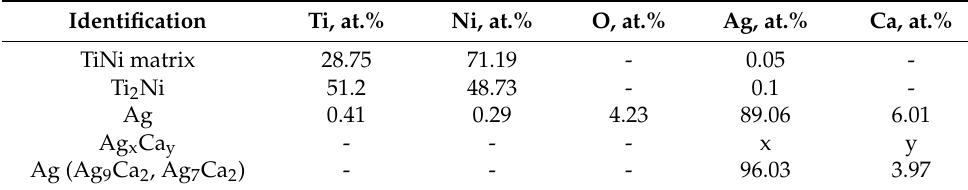
Table 4. Elemental composition of phases in SHS alloys TiNi + 0.5% Ag. Identification